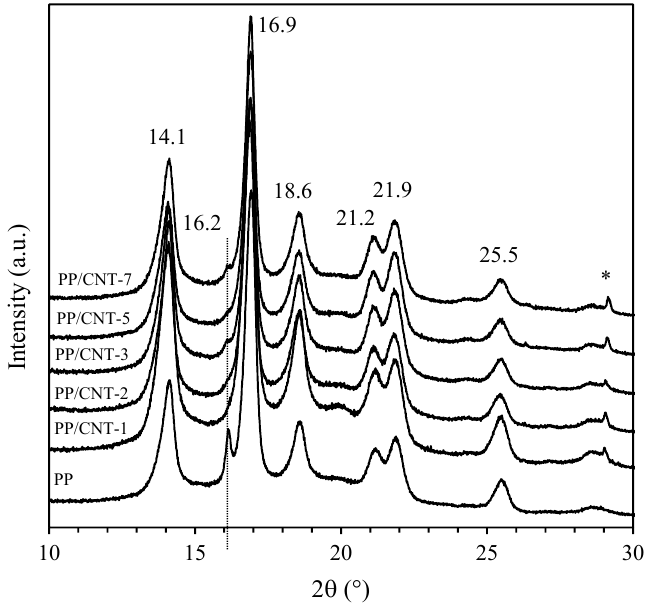
Figure 2. XRD patterns of PP and PP / CNT nanocomposites in the 10–30 ◦ 2 θ range (* is a peak corresponding to catalyst